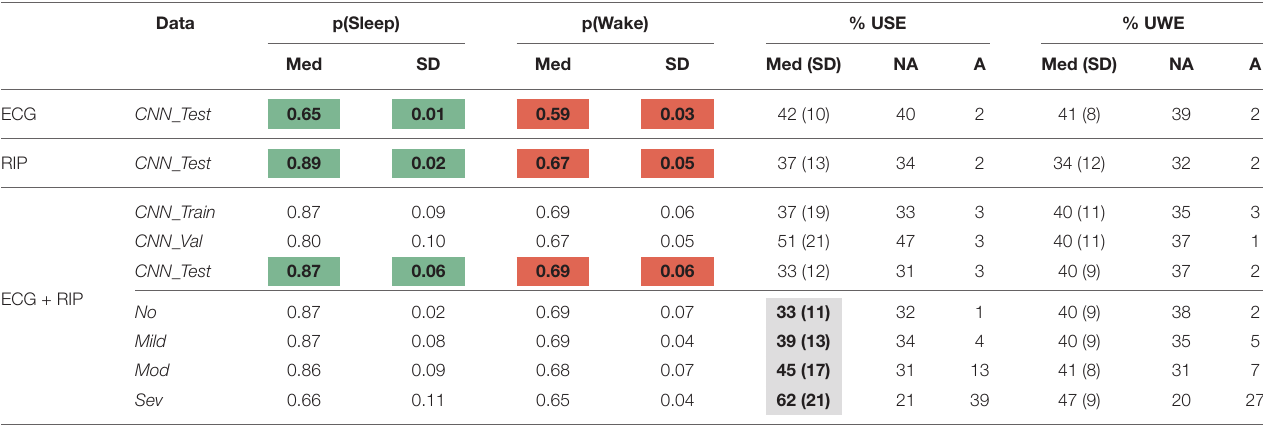
TABLE 3 | Uncertainty in the sleep-wake classifier outcome, averaged over individual patient outcomes.